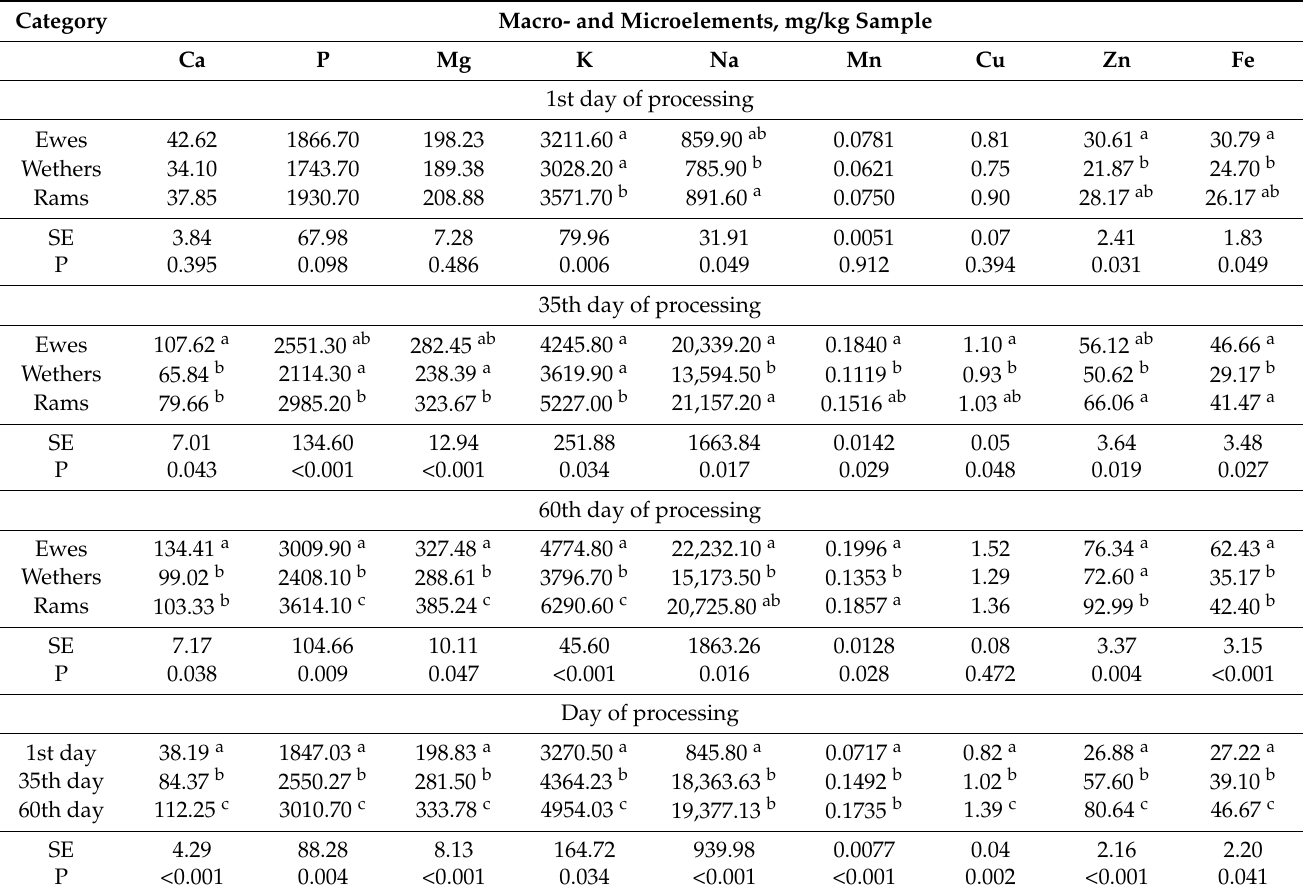
Table 3. Macro- and microelements of different categories of raw mutton and kaštradina in different processing times (mg/kg). Category Macro- and Microelements, mg/kg Sample